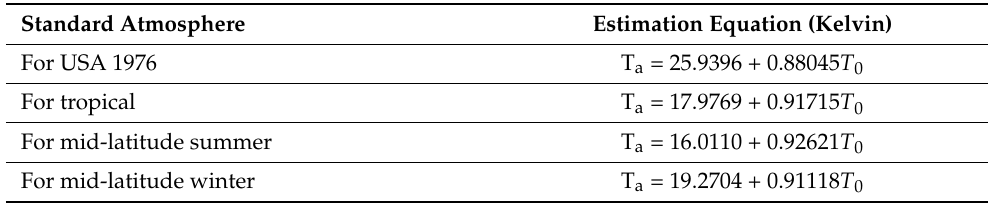
Table 3. The estimation equation for effective mean atmospheric temperature in four standard